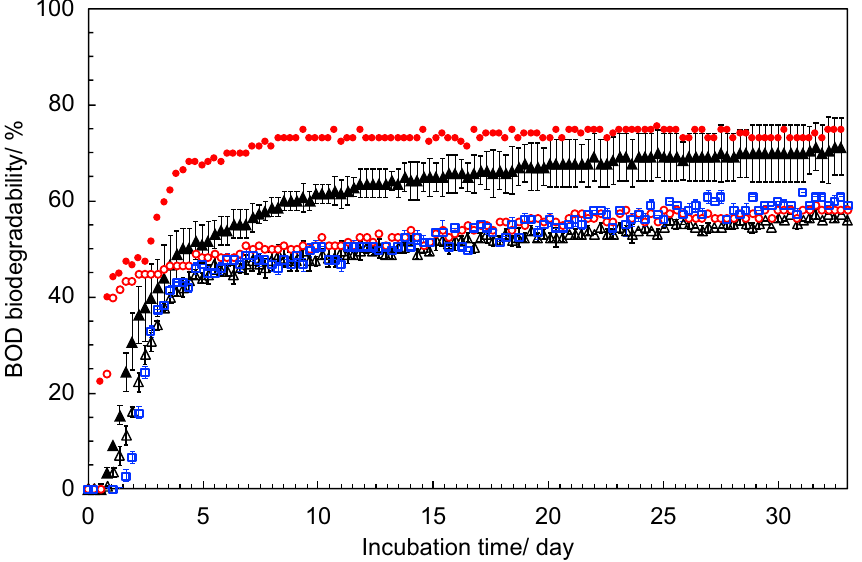
Figure 6. BOD biodegradation curves of amino acids with mixed soil and NH 4 Cl, 5.0 mg L −1 (open circle), amino acids with single-source soil and NH4Cl, 0.50 mg L −1 (closed circle), BP1 with mixed soil and NH4Cl, 5.0 mg L −1 (open square), BP1 with single-source soil and NH 4 Cl, 5.0 mg L −1 (open triangle), and BP1 with single-source soil and NH 4 Cl, 0.50 mg L −1 (closed triangle) at 25 °C for 30 days. Error bars indicate standard error.